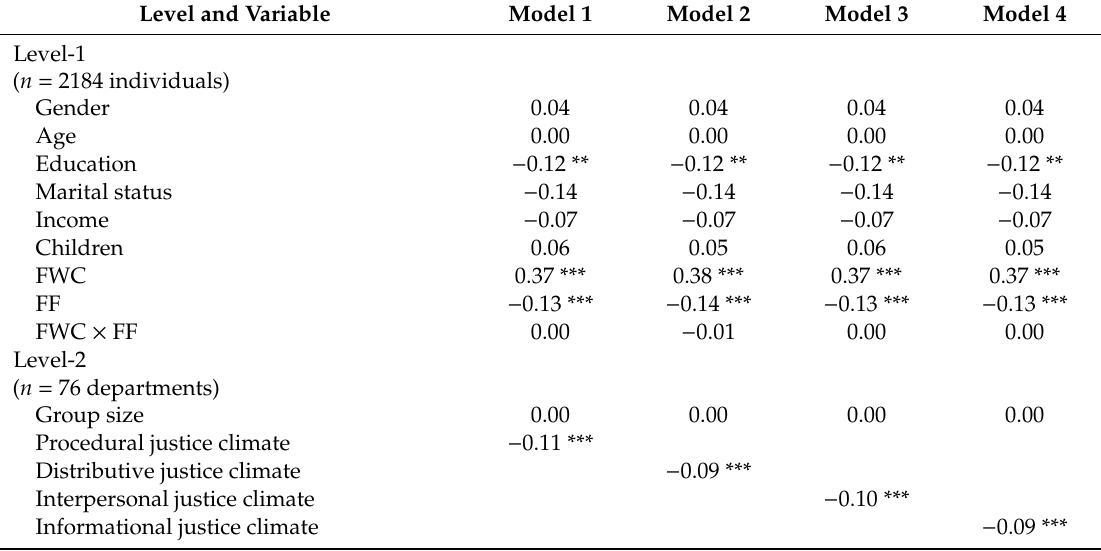
Table 4. Family-to-work conflict and depressive symptoms: Cross-level interactions of organizational justice climate and family